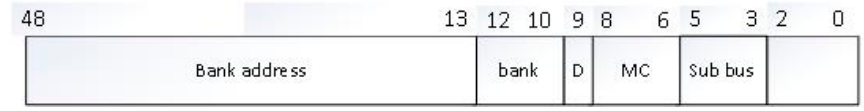
Figure 2. Binary interleave.